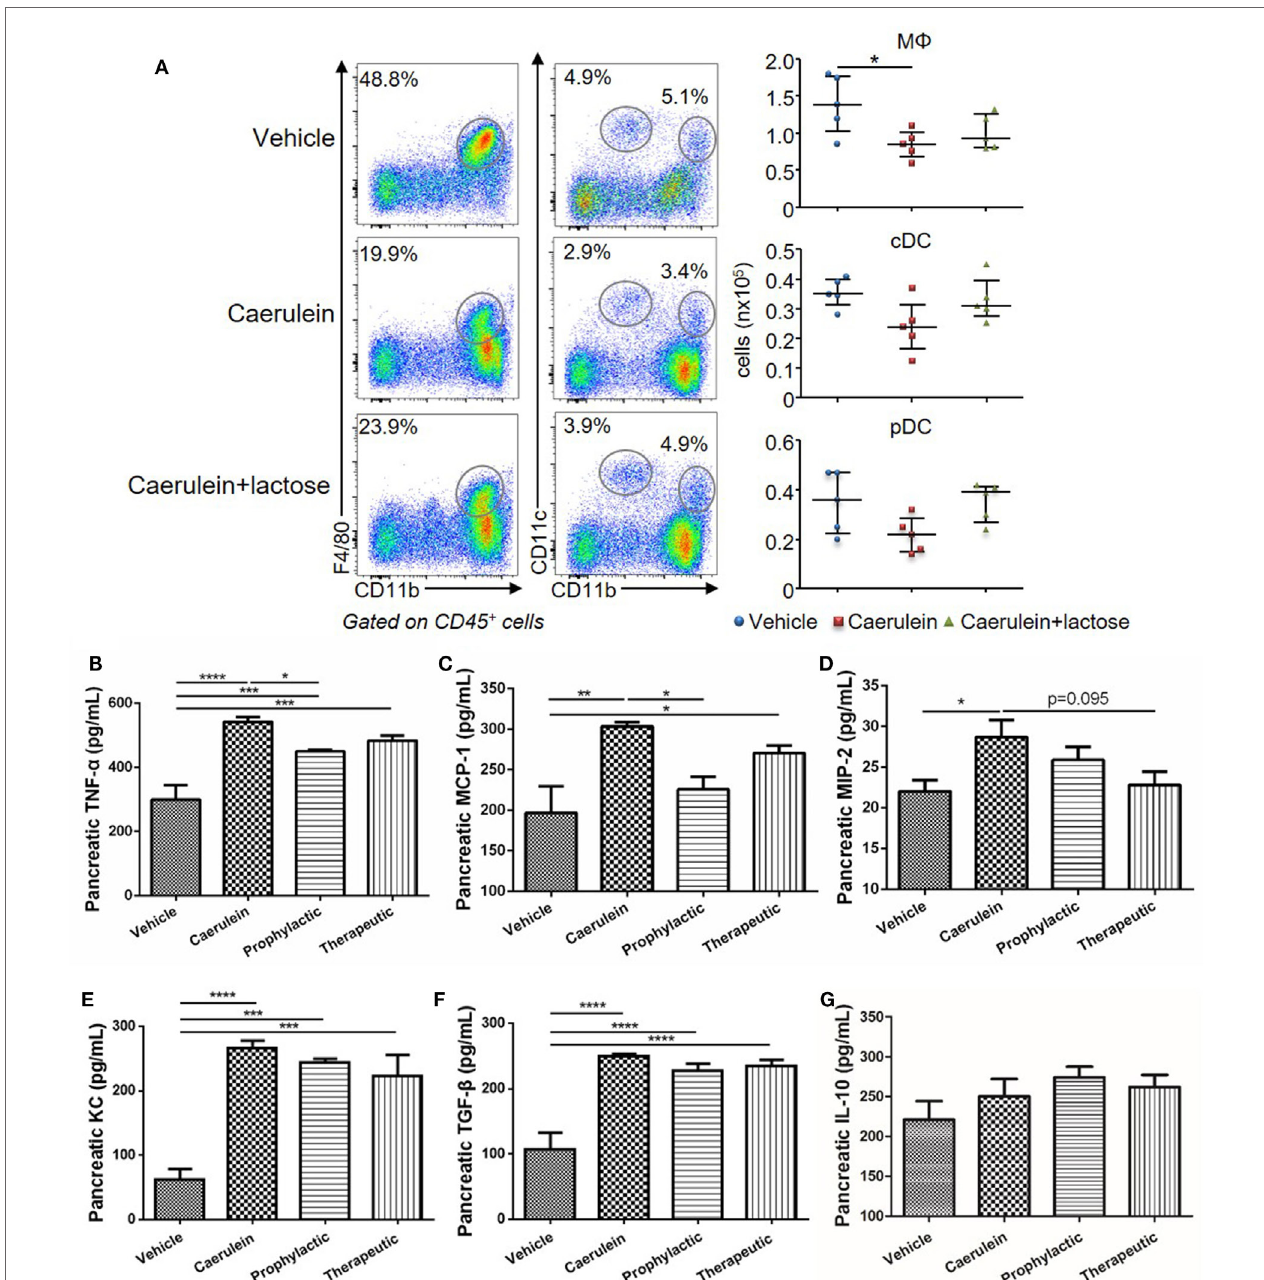
FigUre 2 | Lactose promotes early immune cell infiltration and a modulatory cytokine production profile in the pancreas. Female BALB/c mice were treated with caerulein together with or without lactose and 3 h later cells were recovered from the pancreas. (a) Frequency (gated on CD45 + cells) and absolute number of macrophages (CD11b + F4/80 + ), conventional dendritic cells (F4/80 − CD11b + CD11c + ) and plasmacytoid dendritic cells (F4/80 − CD11b + CD11c med ) per pancreas were shown. Data are representative or median values ± interquartile range from four independent experiments with a minimum of five independent mice. (B–g)